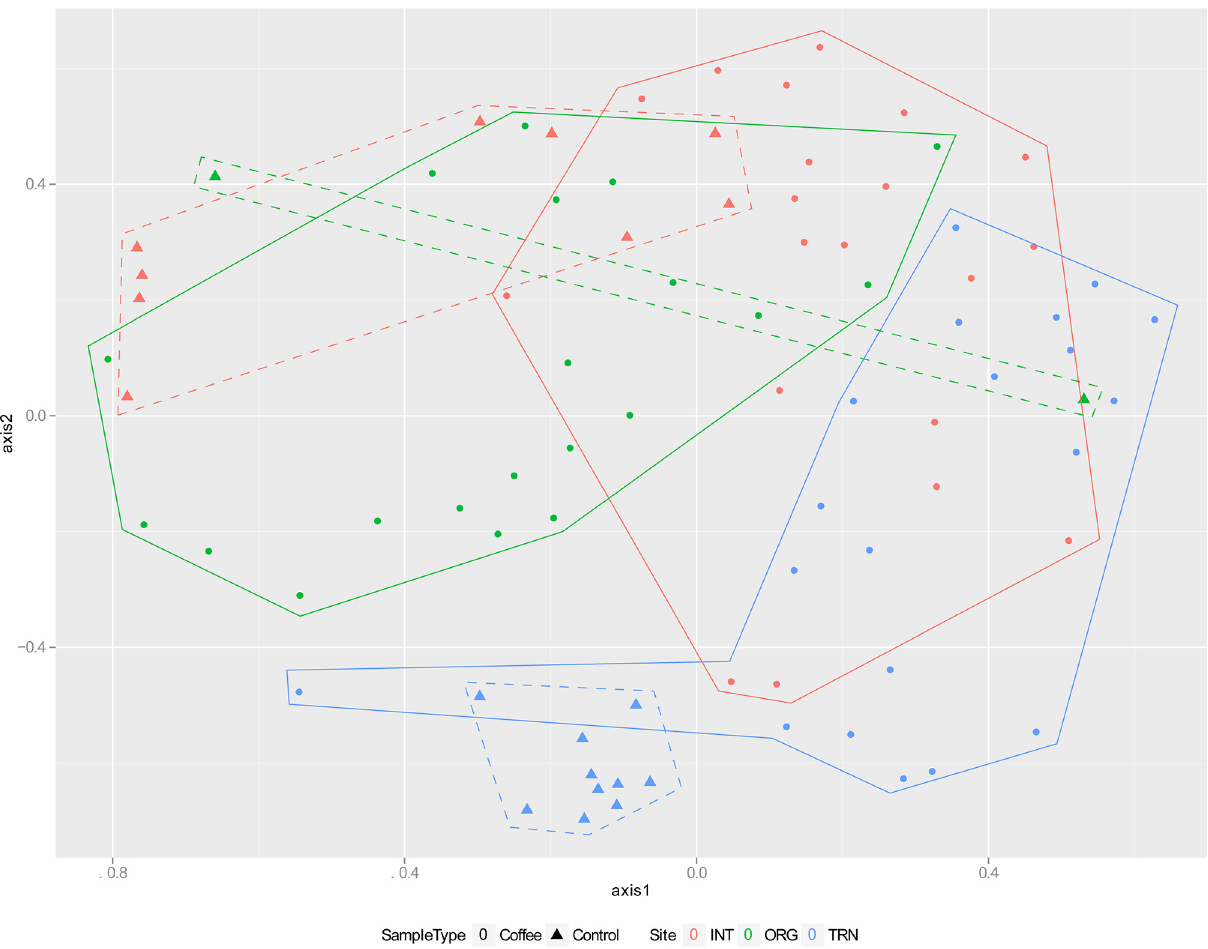
Fig 2. NMDS of species-level OTUs, grouped by site and sample type. NMDS plot, analyzing differences in 97% similarity OTU taxonomy between samples. NMDS axes calculated in mothur, results plotted in R. Number of random configurations tested = 1000, with 10000 iterations of each configuration. R 2 = 0.711. Lines indicate clustering of samples in each site-sample type combination. Sites were INT, TRN, and ORG whereas sample types included either coffee rhizosphere or soil